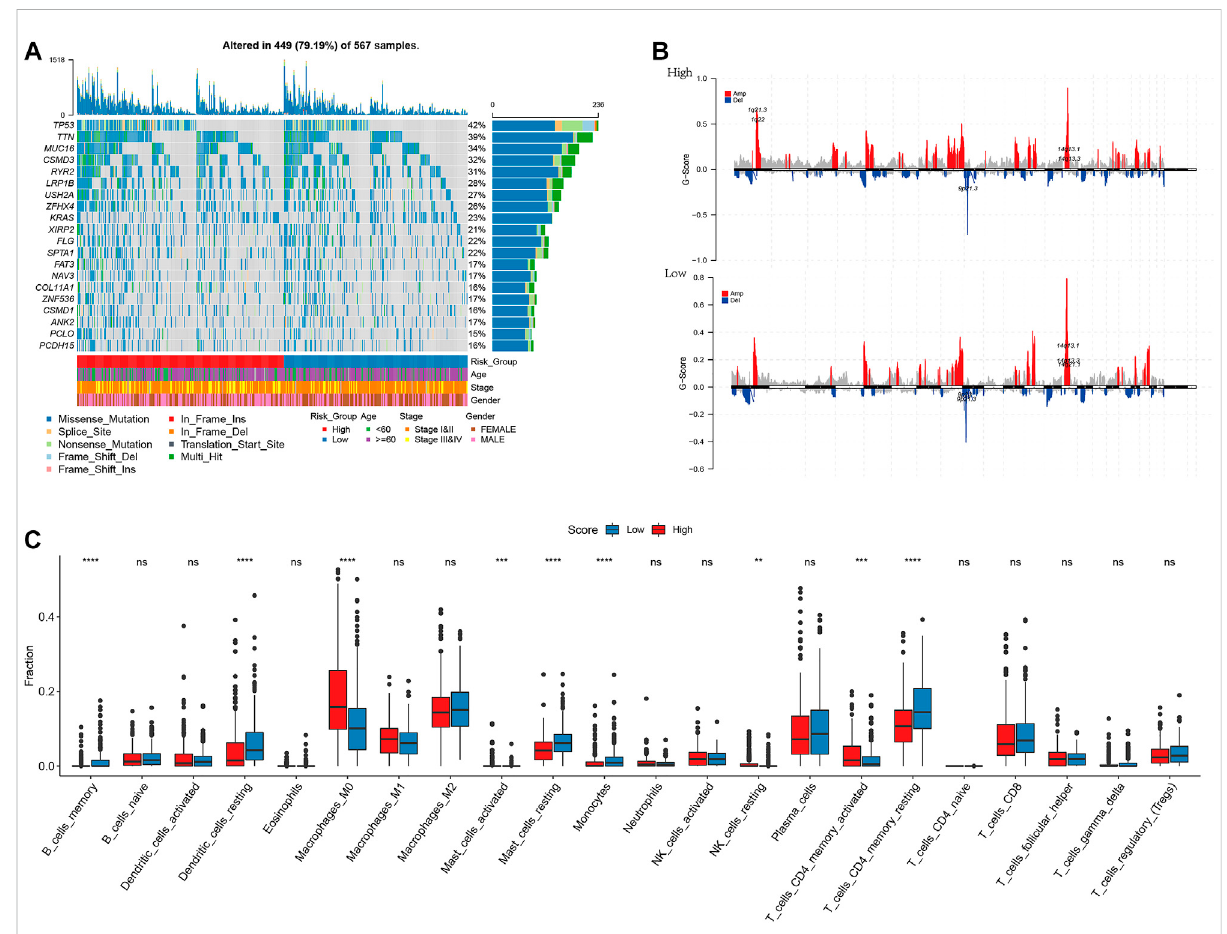
FIGURE 8 Iplottedthewaterfallandselectedthetop20geneswiththehighestfrequencyofmutations (A) ;Ampli fi cationanddeletionofchromosomesin thehigh-low risk groups (B) ;Differential results ofimmune in fi ltration inhigh-low risk groups (C) .* p < 0.05, ** p < 0.01,*** p < 0.001,**** p <